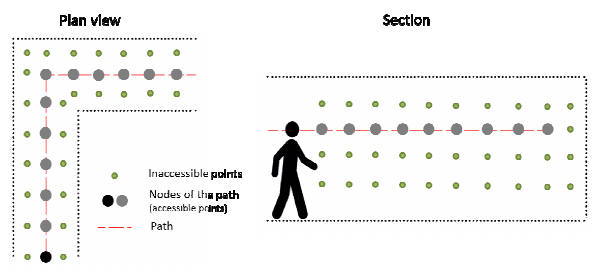
Figure 8. Representation of the three-dimensional grid for the 3D visibility graph approach